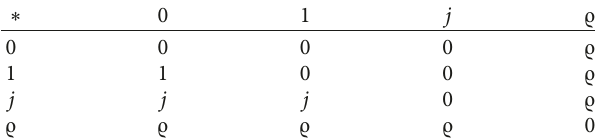
Table 4: Cayley table of the binary operation ∗